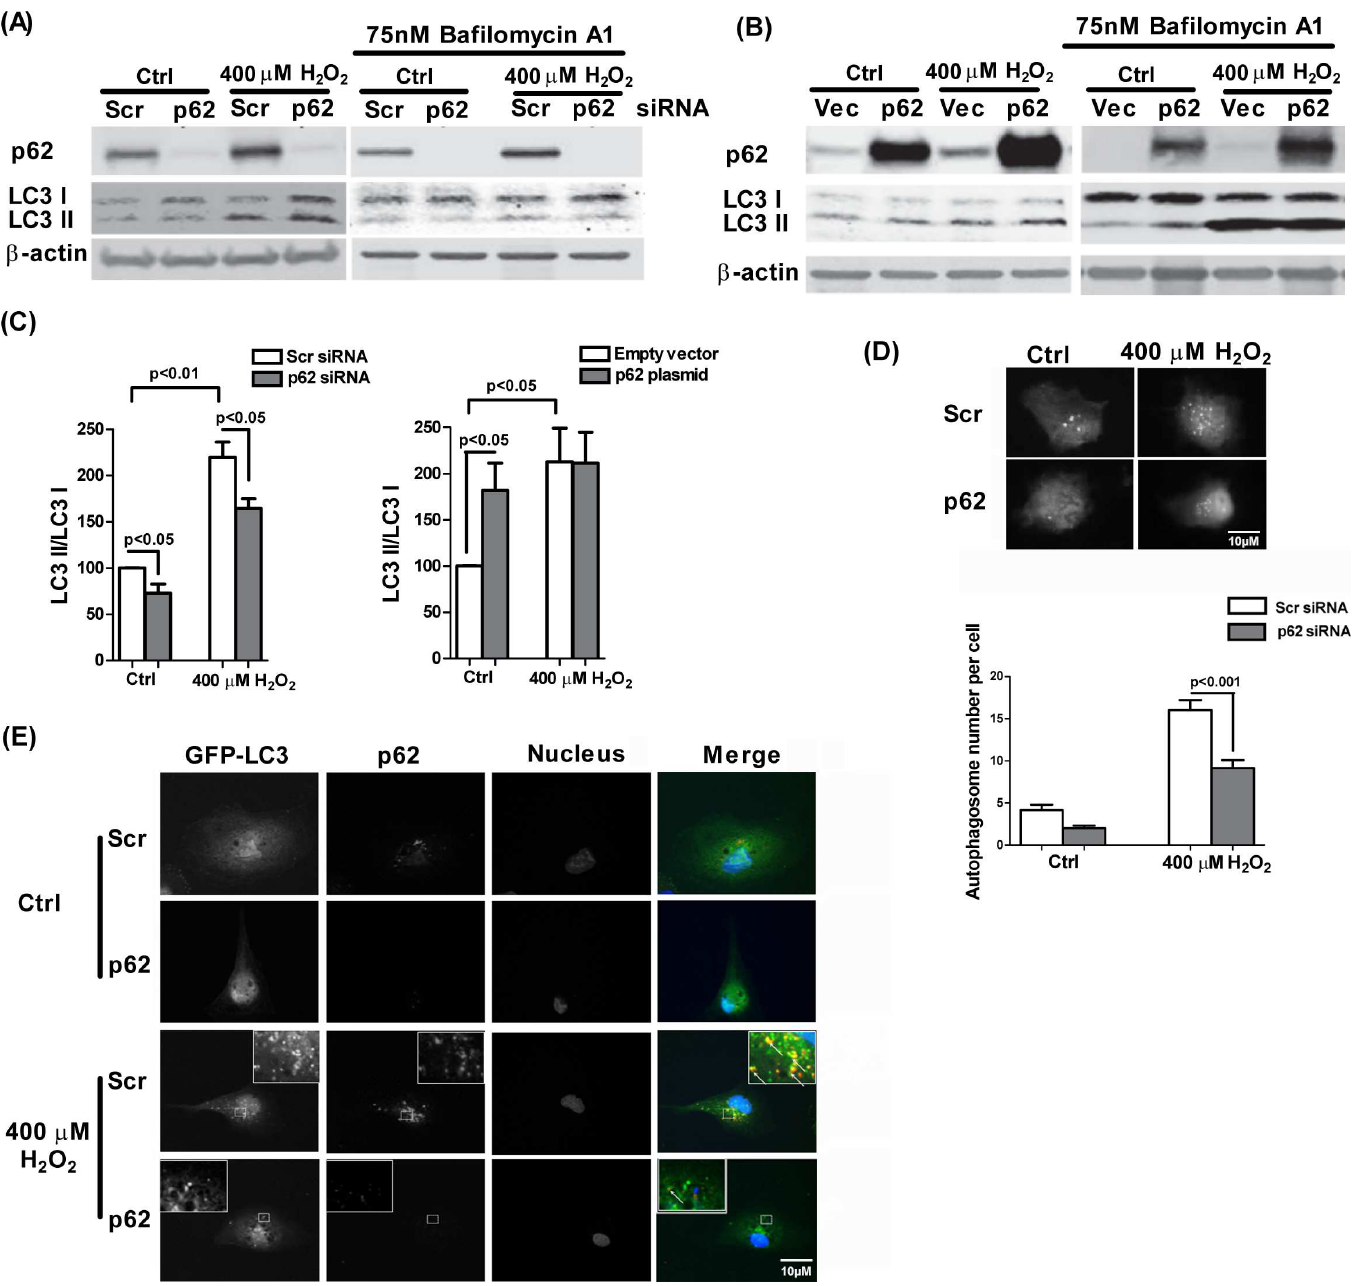
Fig 7. p62 positively regulates autophagic flux. LC3II/I ratio and p62proteinlevelsin cell lysateswere examinedby Westernblot for (A) ARPE-19cells, transfectedwith p62 specificsiRNA or scrambledsiRNA (10nM)for 24h andtreatedwith 400 μ MH 2 O 2 for additional24 h. For assessment of autophagic flux, BafilomycinA1 (75nM)was added3h priorto harvesting in one set of treatmentsper experiment. (B) RPE cellstransfectedwithp62 constructor empty vector for 24h andtreatedwith 400 μ MH 2 O 2 for an additional24 h. β -actinwas usedas an internalcontrol. (C) Densitometric analysesof LC3 II/I ratio in (A = endogenous p62 knock-down and B = ectopicoverexpression of p62) were plottedas mean+ S.E.M. of three independent experiments. Meandifferenceswere considered statistically significant whenp < 0.05by Mann-WhitneyU-test. (D) Autophagosomenumberswere determinedin RPE cells co-transfected with GFP-LC3 and p62 siRNAor scrambled siRNA(10nM), after H 2 O 2 treatment. 50 cells perconditionper experimentwere analyzedfor autophagosomenumbers.Differences betweenmeancounts from 3 independent experiments were consideredstatisticallysignificantwhenp < 0.05by Mann-Whitney U-test. (E) RPE cellstransfected with GFP-LC3togetherwithp62 siRNA or scrambledsiRNA for 24hand treatedwith400 μ MH 2 O 2 for additional 24hwere fixed andimmunostainedfor p62. AlexaFluor ® 594-conjugated goat anti-mousesecondaryantibodywas usedfor visualization. White arrowsrepresentthe co-localization of p62(red) and GFP-LC3